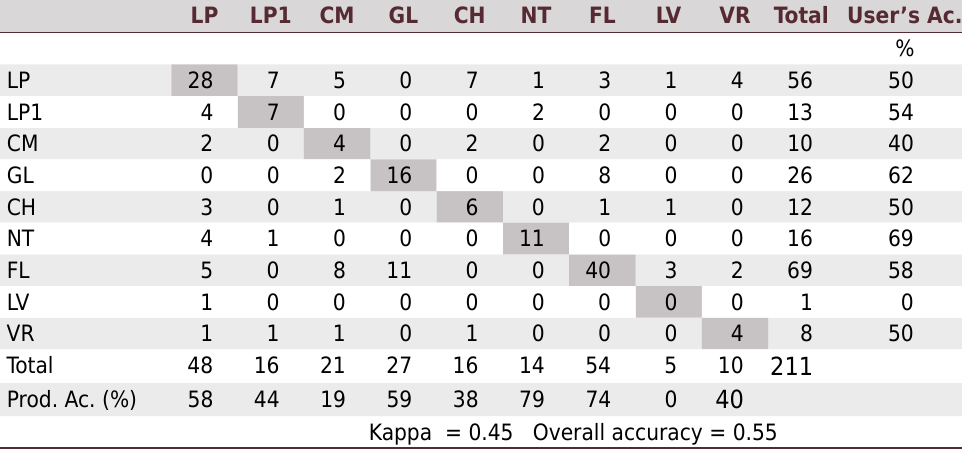
Table 4. Confusion matrix of soil classification using Multinomial Logistic